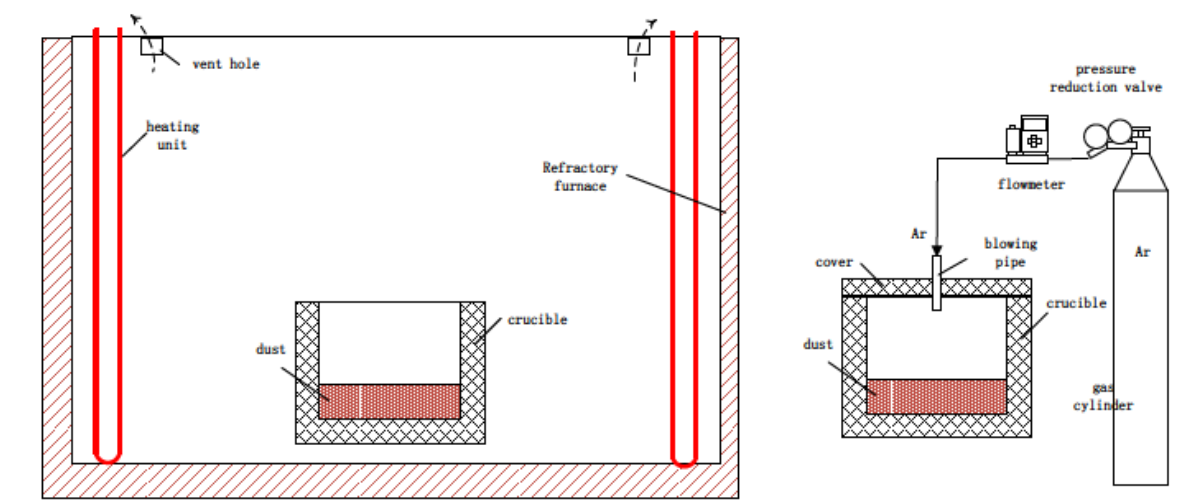
Figure 6: Experiment system for experiment (b) involving at different roasting temperatures